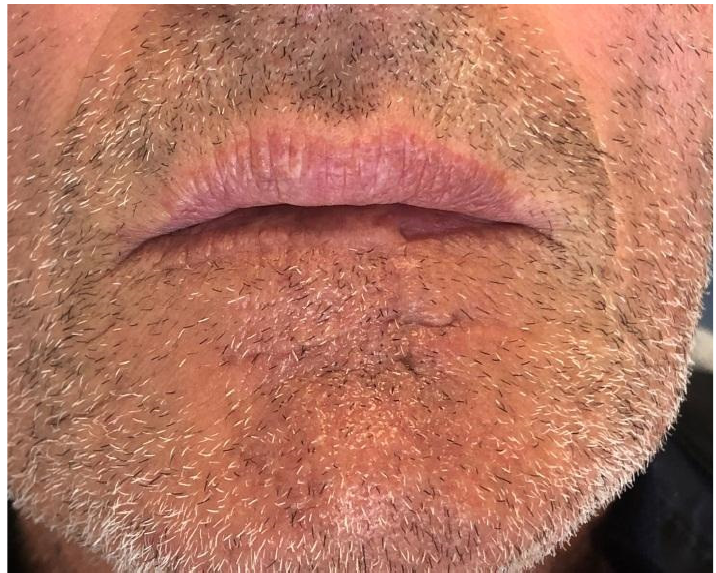
Figure 2. Case 1: Postoperative view.